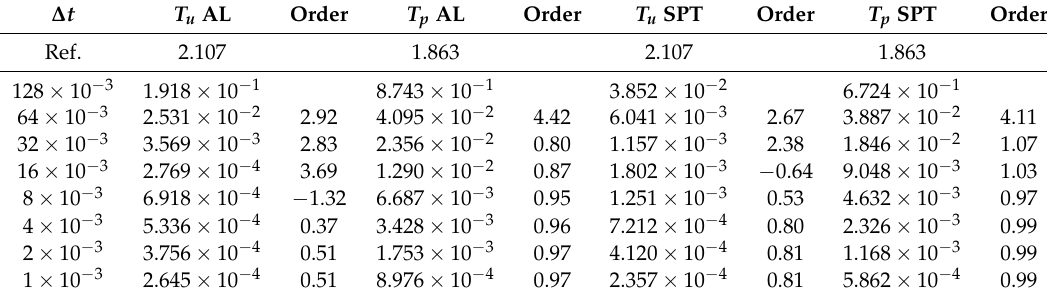
Table 6. Temporal convergence of the error on the velocity and the pressure for the augmented Lagrangian and the rotational pressure-correction methods—Gear 2 scheme for the Couette flow. ∆ t T u AL Order T p AL Order T u SPT Order T p SPT Order